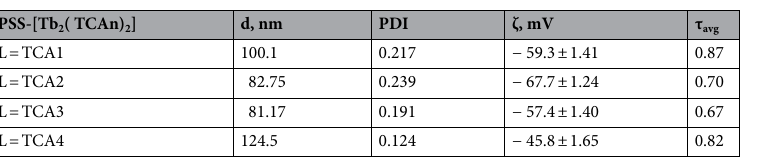
Table 1. The average sizes (d), electrokinetic potential values (ζ), polydispersity indices (PDI) evaluated from the DLS measurements of PSS-[Tb 2 (TCAn) 2 ] (0.75